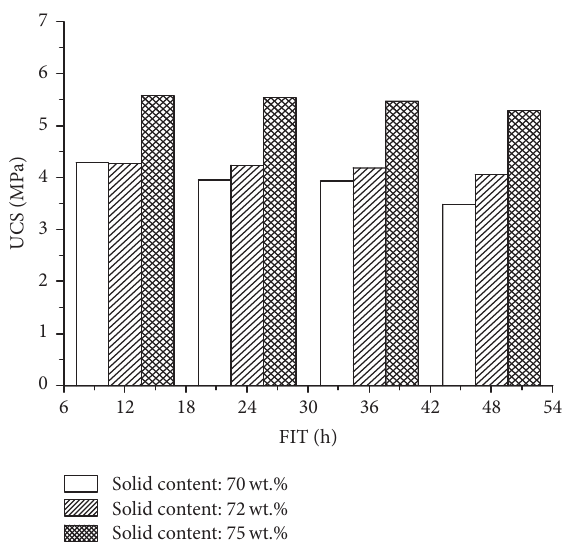
Figure 5: Relationship between uniaxial compressive strength and filling